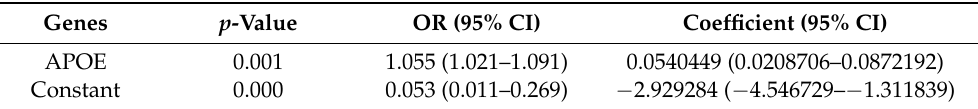
Table 10. Final Advanced Stage EC patients vs. controls model: sensitivity/specificity plot for the resulting multivariate logistic regression model for sensitivity levels higher than specificity levels.